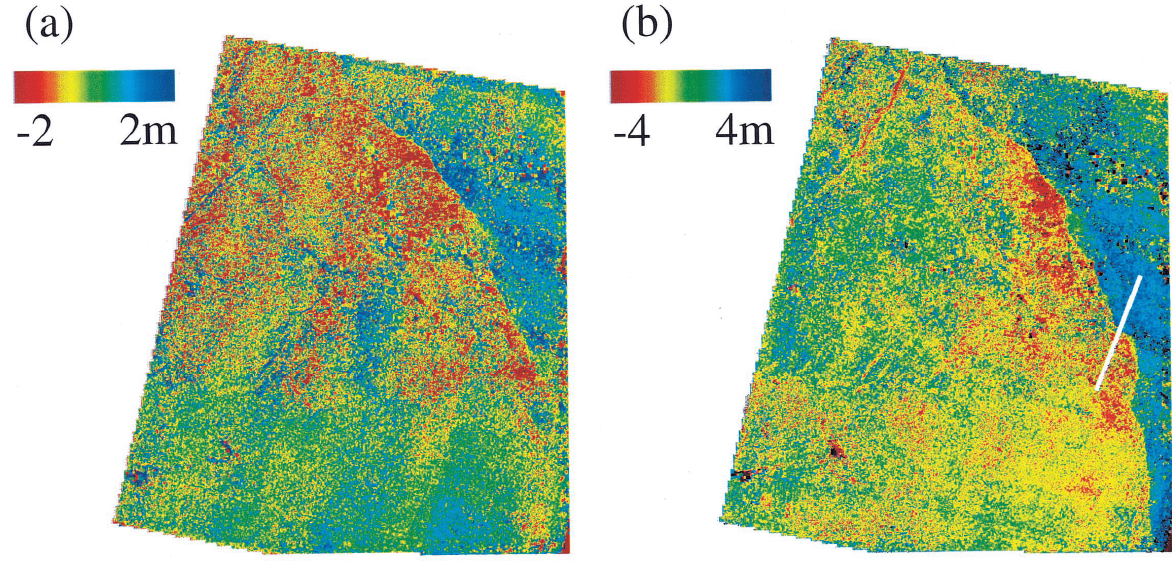
Figure 3. Horizontal ground displacement induced by the Landers earthquake measured from SPOT2 panchromatic images (pixel size 10 m). (a) East-West. (b) North-South components